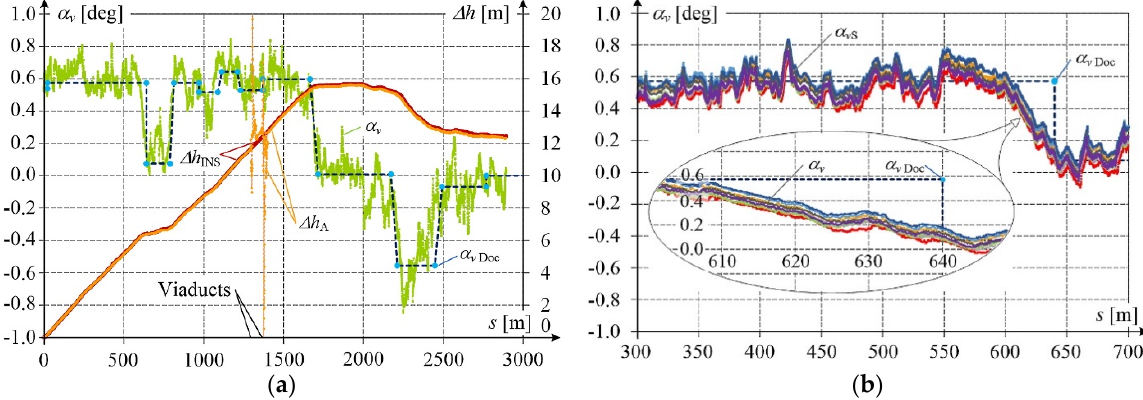
Figure 11. Height and longitudinal inclination angle of the track: ( a ) relative track position height changes: Δ h INS from INS and Δ h A from GNSS receiver A , and longitudinal inclination angles: α v from measurement and α v Doc from documentation; ( b ) in expanded scale from multiple passages.